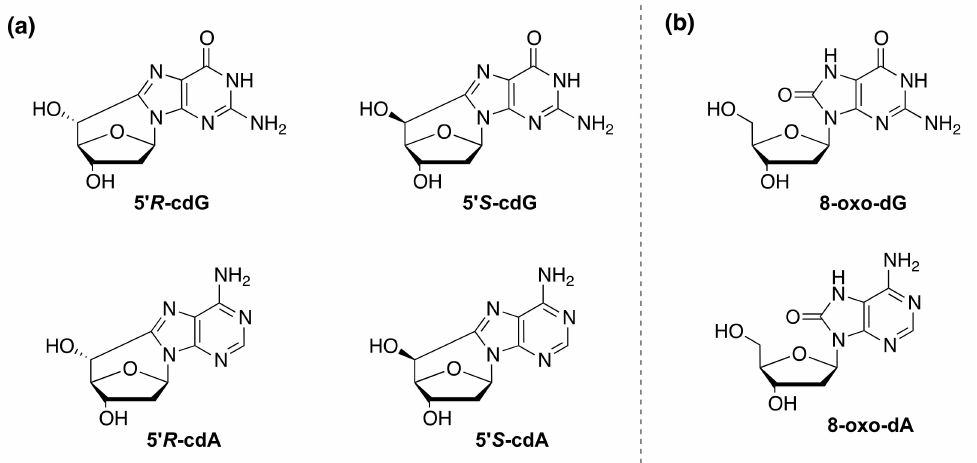
Figure 1. ( a ) Structures of 5 (cid:48) ,8-cyclo-2 (cid:48) -deoxyguanosine (cdG) and 5 (cid:48) ,8-cyclo-2 (cid:48) -deoxyadenosine (cdA) in their 5’ R and 5’ S diastereomeric forms. ( b ) Structure of 8-oxo-2 (cid:48) -deoxyguanosine (8-oxo-dG) and 8-oxo-2 (cid:48) -deoxyadenosine